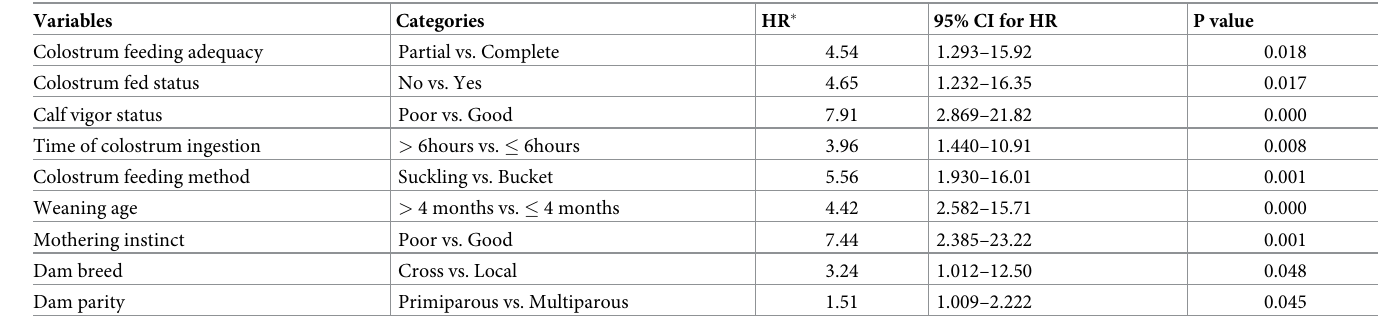
Table 8. Potential risk variables significantly associated with the incidence of crude calf mortality based on univariate analysis using Cox